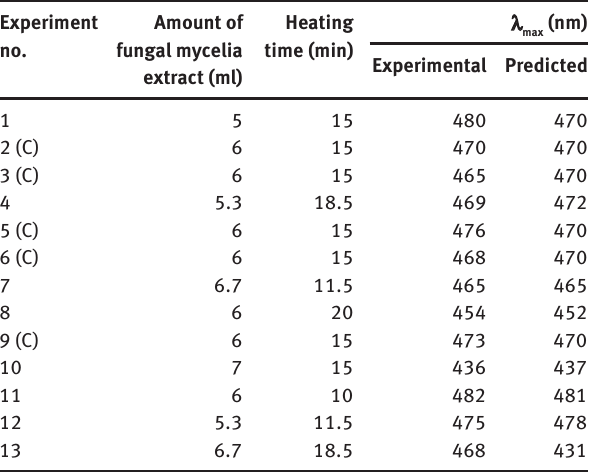
Table 1: Central composite design and response variables for the final model.